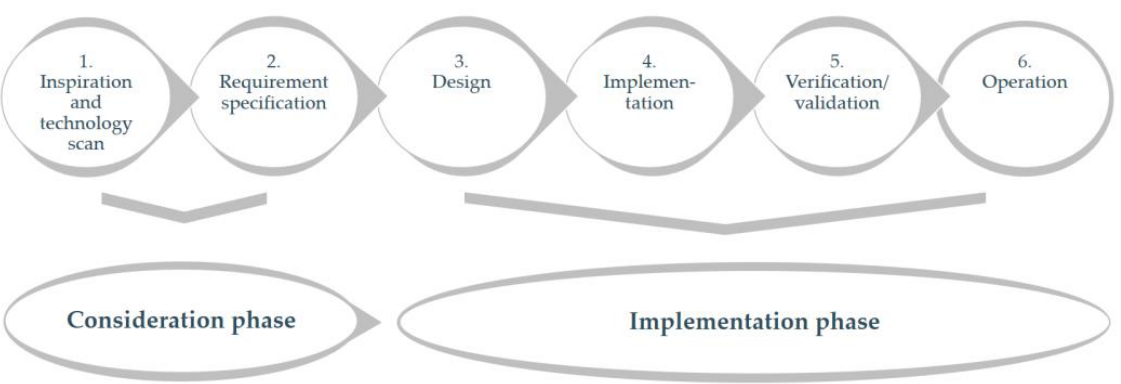
Figure 2. Cobot consideration and implementation phase adapted from the HRC life cycle model from Saenz et al. [32].